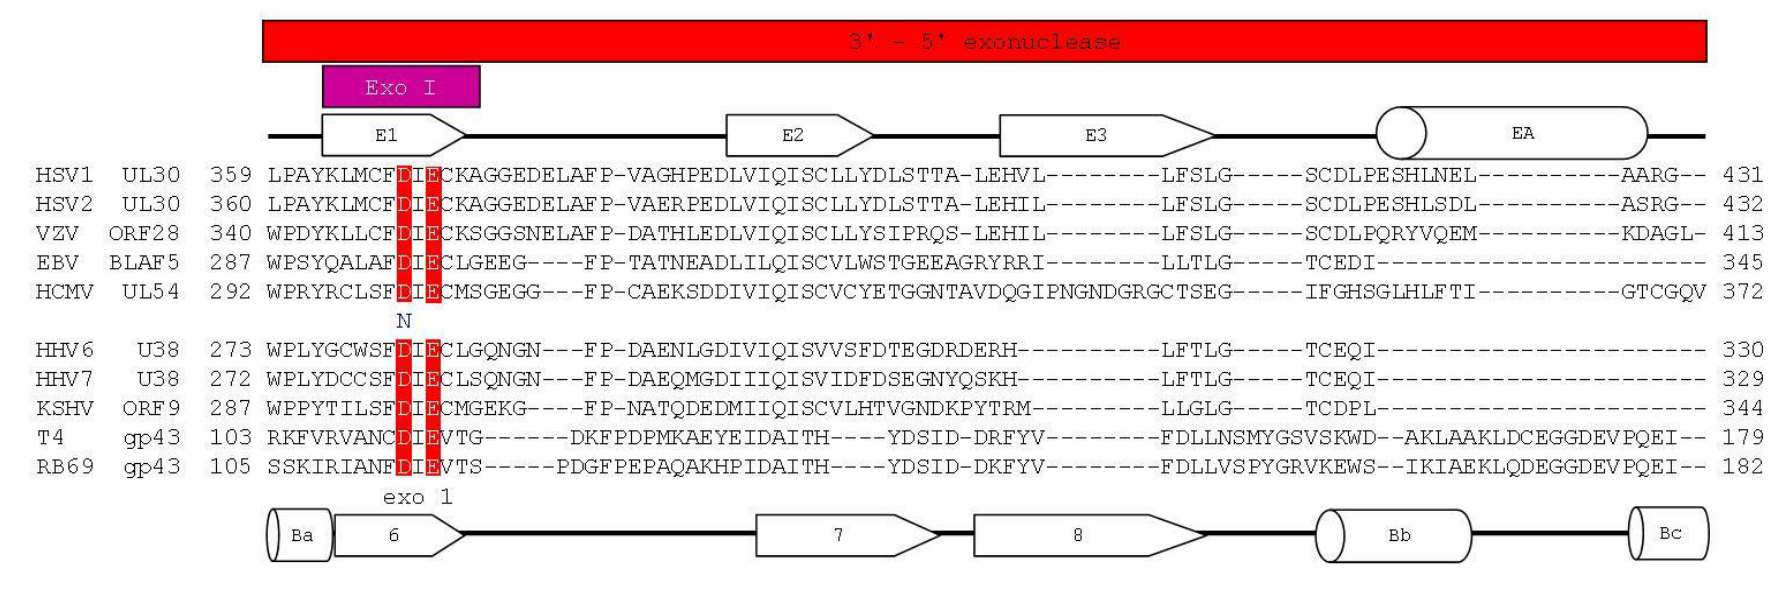
Appendix Figure A1.